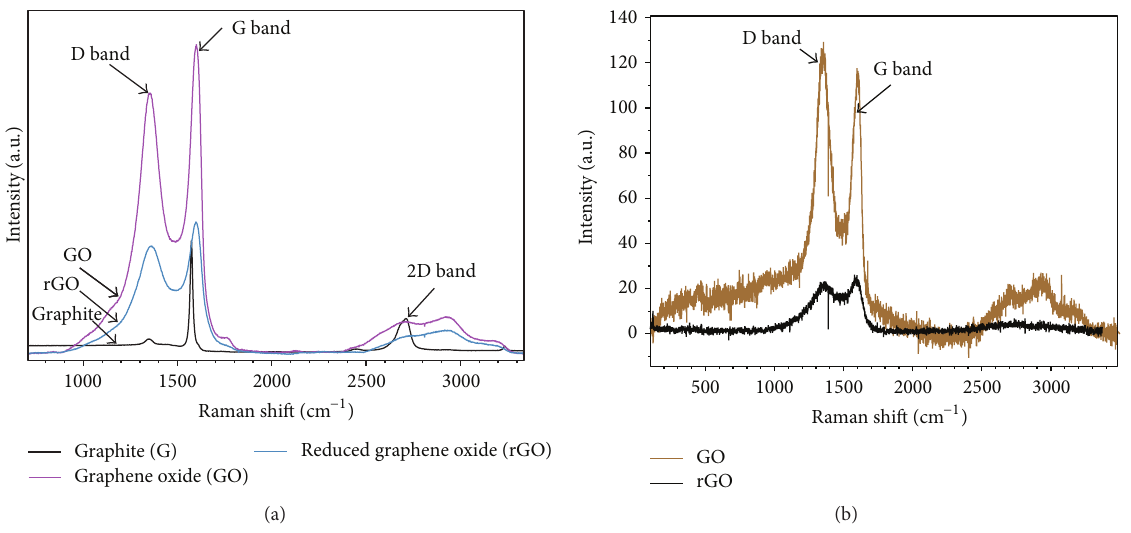
Figure 2: Raman spectra of graphite (G), graphene oxide (GO), and reduced graphene oxide (rGO).